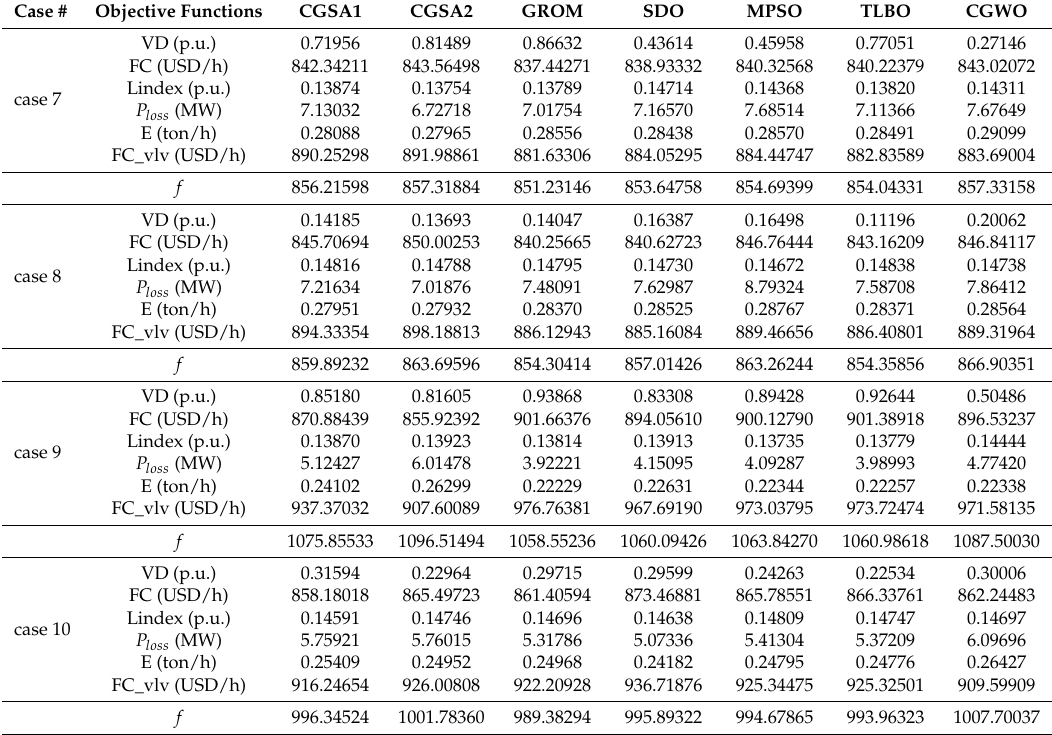
Table 6. Results of the GROM algorithm and other optimization algorithms for the multi-objective OPF for IEEE 30-bus